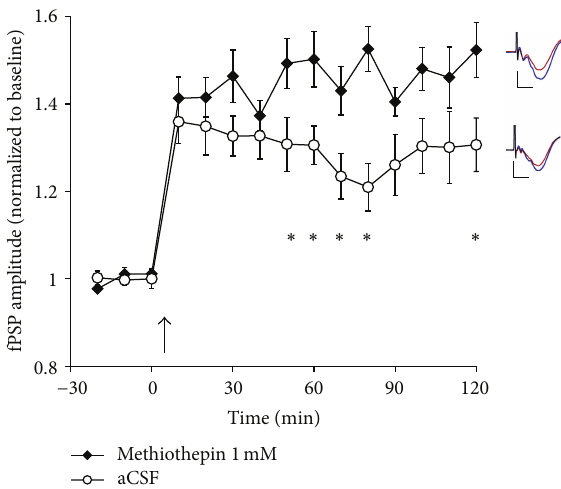
Figure 5: The effect of application (in V1 by means of reverse microdialysis) of either aCSF ( 𝑛 = 8 ; same group as in Figure 3) or WAY 100635 (1mM, 𝑛 = 10 ) on LTP following TBS (at arrow) of the LGN in urethane-anesthetized rats. Application of WAY 100635 resulted in a significant increase in LTP relative to control animals. Inserts depict typical fPSPs before (red) and after (blue) LTP induction in the presence of WAY 100635 (top) and aCSF (bottom; calibration bars indicate 0.5 mV vertical and 10ms horizontal; each fPSP trace is an average of 30min of continuous recording). ∗ indicates a significant ( 𝑃 < 0.05 , 𝑡 -test) difference between the two